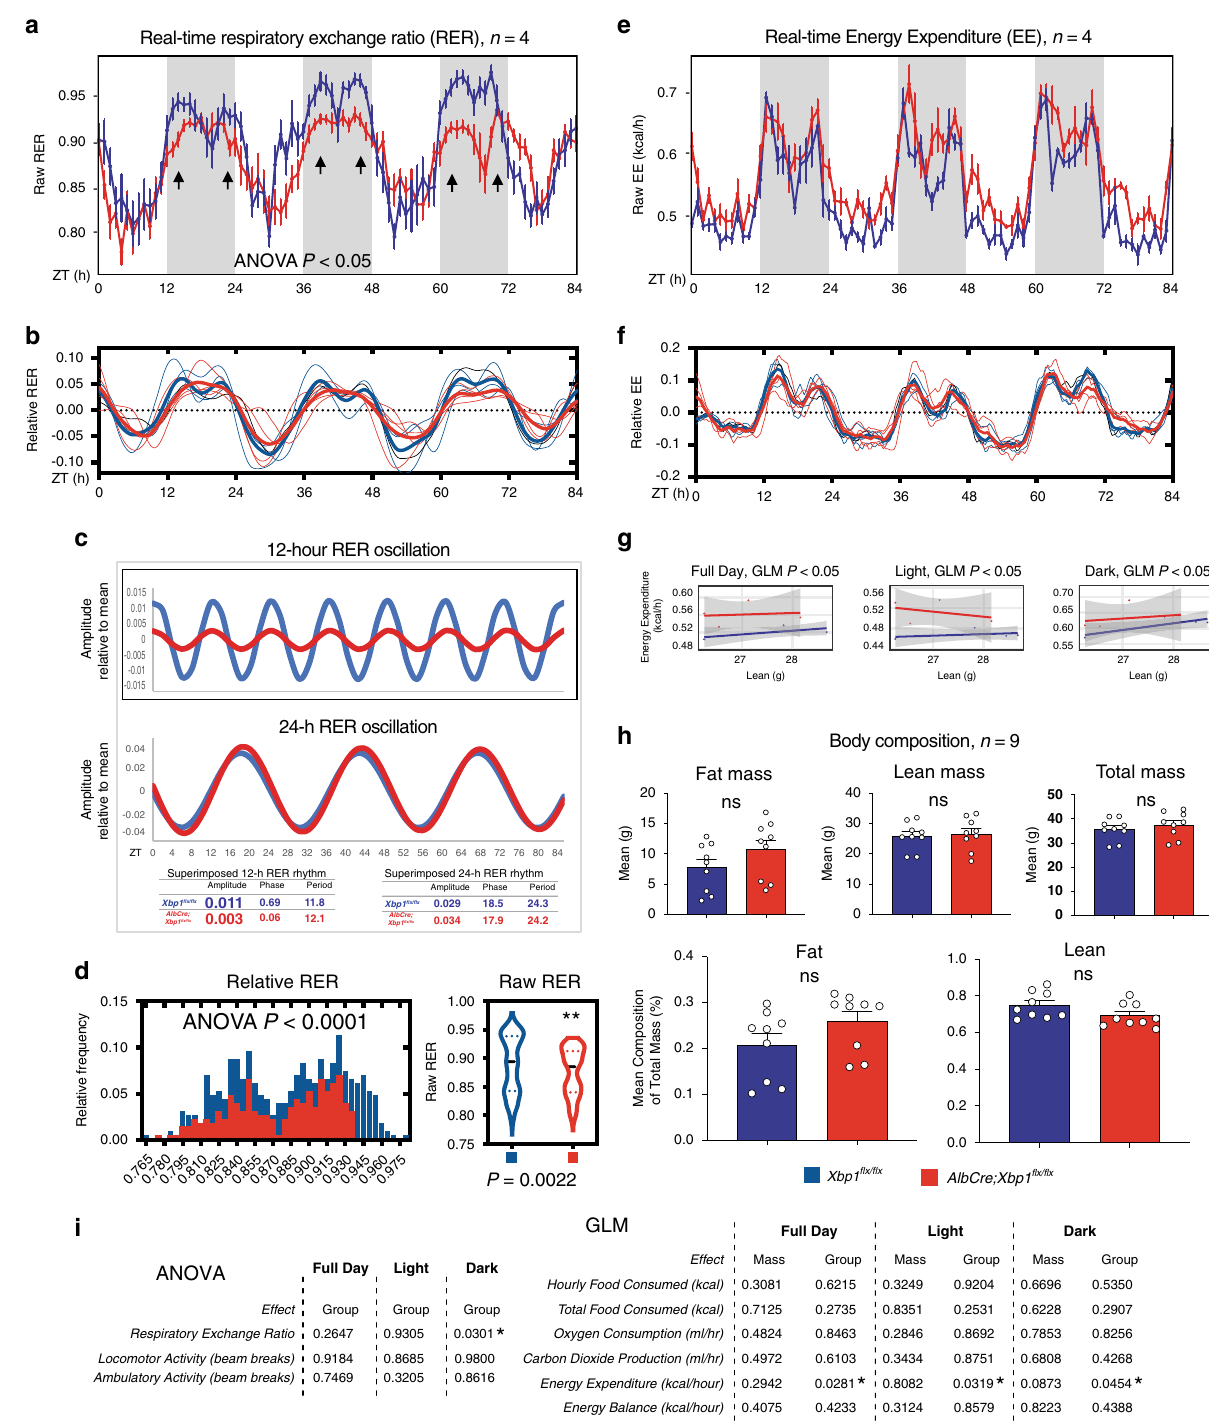
OCT compound. Oil Red O staining was used to visualize neutral lipid accumulation. Statistics and reproducibility . Statistical analysis was conducted using GraphPad Prism 8 software. All data were tested for normal distribution of variables. All normally distributed data were displayed as the means ± standard error of the mean (SEM), unless otherwise noted. Measurements between two groups were performed with an unpaired Student ’ s t -test (two-tailed p value) unless otherwise noted. Non-signi fi cant p values are shown as ns. Each in vivo and in vitro experiment was performed with the number of replicates speci fi ed in the fi gure legends. All data obtained are shown; all data are shown in the quanti fi